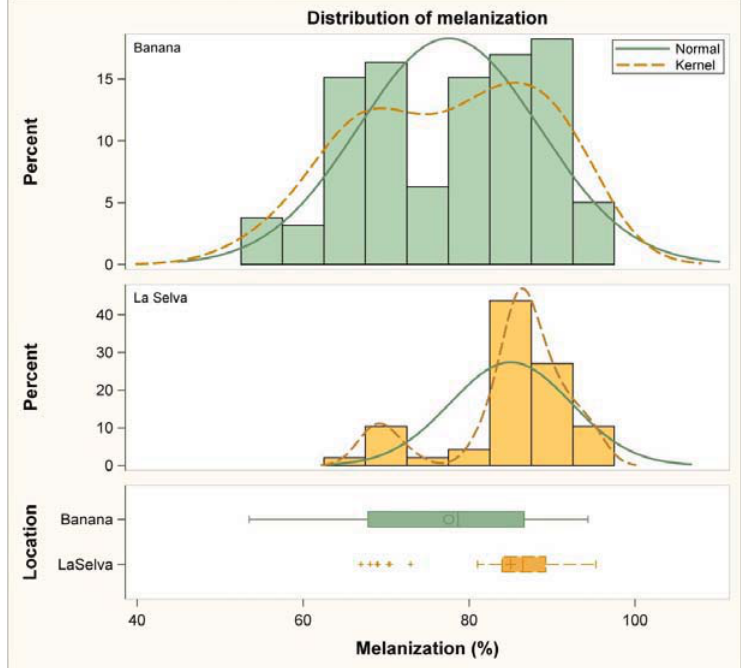
Figure 3. Histogram of the melanization response for the individuals feeding on pesticide leaves from the banana plantations (top panel) and those feeding on pesticide-free leaves from the La Selva forest (middle panel). Box plot of melanization from the two locations is on the bottom